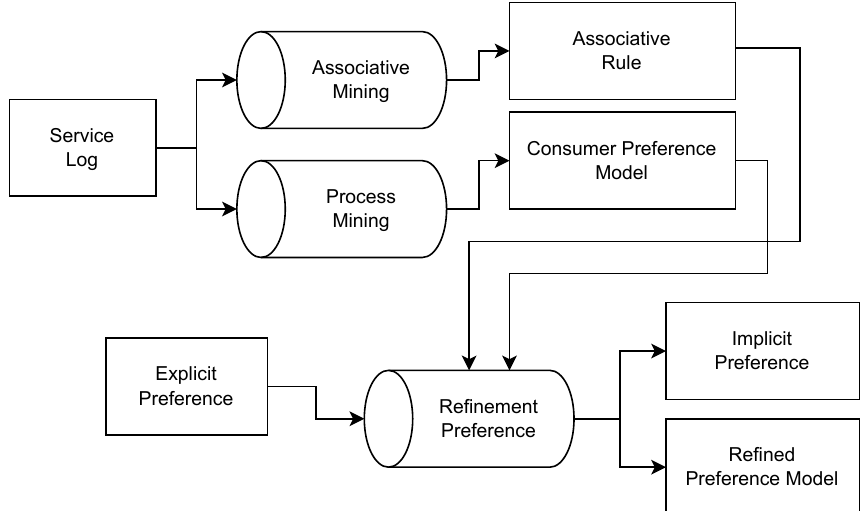
Figure 3. Our approach. We used data mining and process mining to extract the customer behav- ior model.